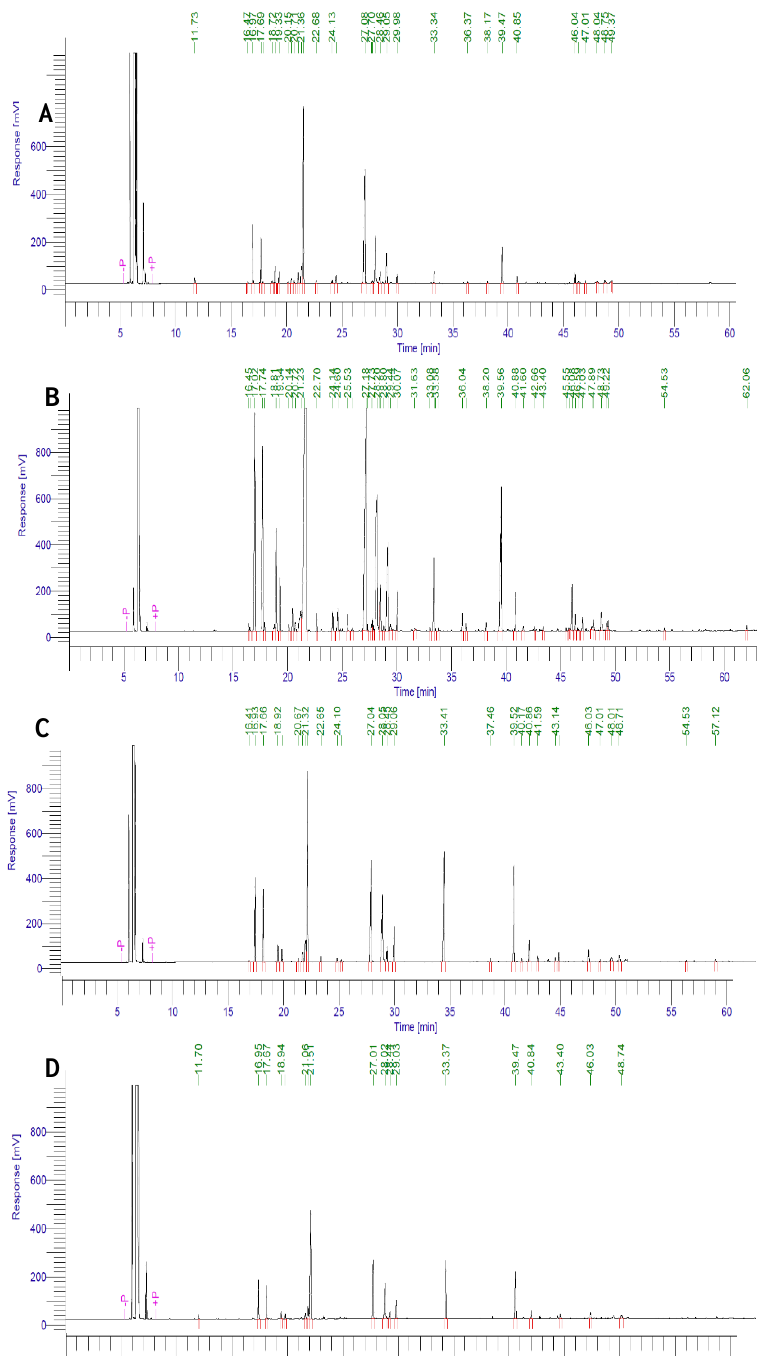
Figure 1. The gas chromatography (GC) chromatograms of rosemary’s volatile oils obtained from fresh ( A ), one-week dried ( B ), two-weeks dried ( C ), and three-weeks dried ( D ) herbs showed major differences in the number of peaks and their relative intensities in rosemary oil batches.